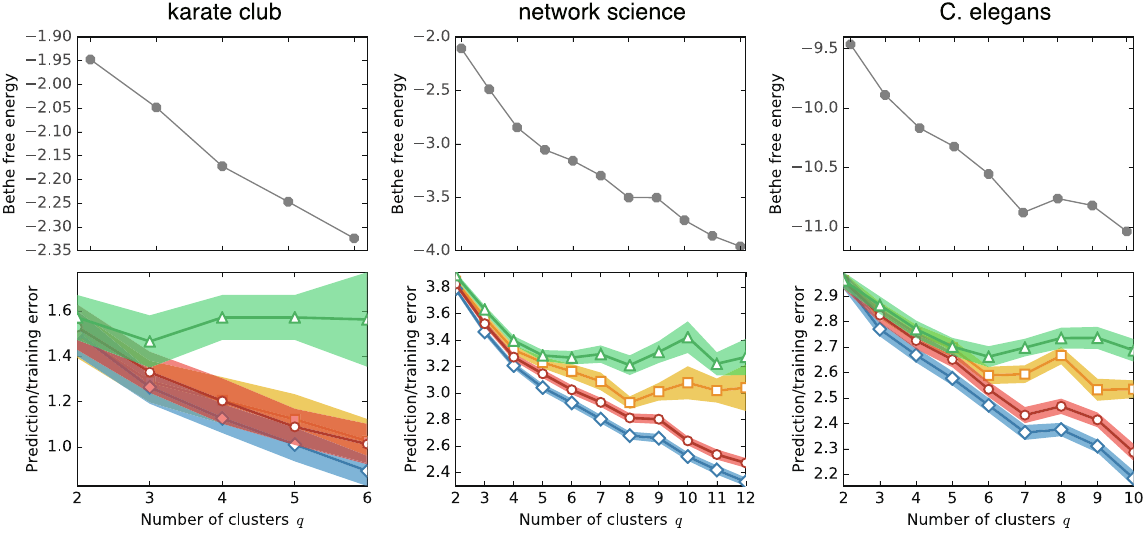
Figure 4. Results of model assessments for various real-world networks. They are plotted in the same manner as Fig.